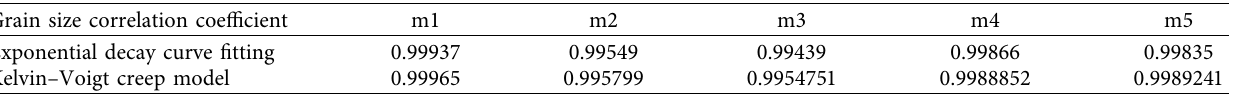
Table 5: Comparison of correlation coefficients of the Kelvin–Voigt model and the fitting curve of first index decay of fragmentized coals with different grain